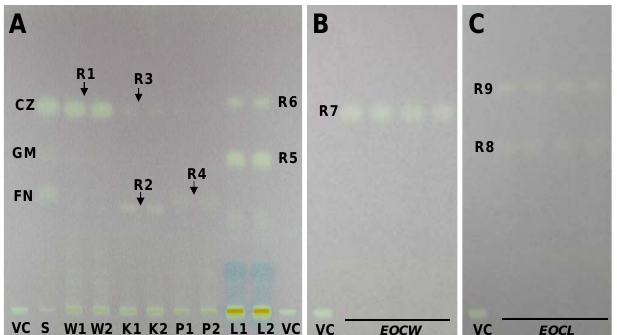
K1VC VCS K2 P1 P2 L1 L2W2W1 EOCW EOCL VC, Vitamin C; S , mixed standards; CZ , curzerene; GM , germacrone; FN , furanodienone; R1-R9 , the bands with obvious antioxidant activity; W1, W2 , two selected samples of C. wenyujin ; K1, K2 , two selected samples of C. kwangsciensis ; P1, P2 , two selected samples of C. phaeocaulis ; L1, L2 , two selected samples of C. longa .